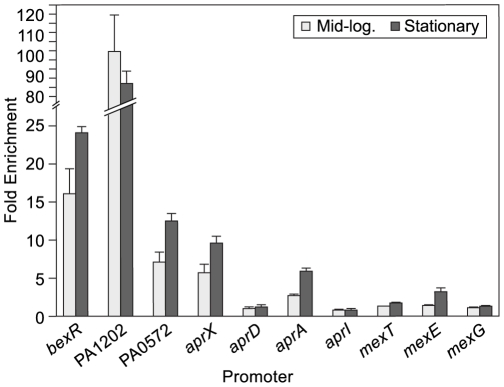
BexR occupies the promoters of target genes.ChIP of an epitope-tagged version of BexR reveals preferential binding of the promoters of target genes over a non-binding control region in vivo at both mid-logarithmic and stationary phase. Error bars represent 1 SD from the mean fold enrichment.